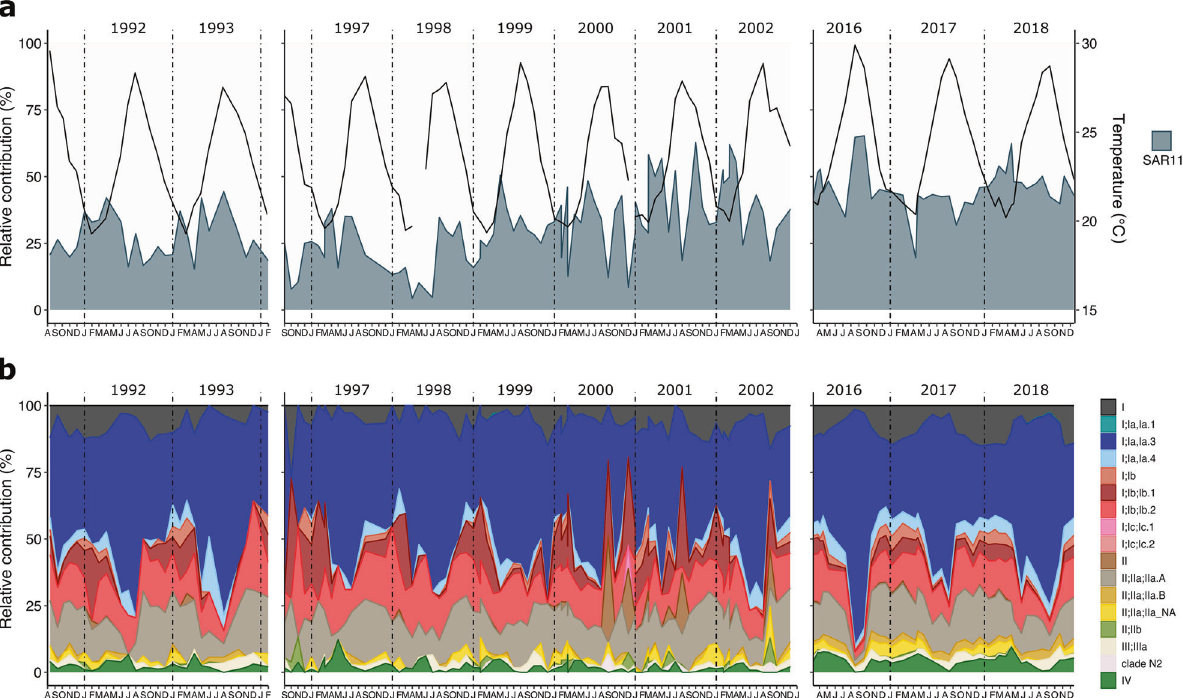
Fig. 1 Monthly relative contribution of surface SAR11 ecotypes through multiannual 16S rRNA surveys at the Bermuda Atlantic Time Series. a Monthly relative contribution of the SAR11 fraction to the total of the amplicon dataset. The black line represents temperature through the sampled years. b Monthly relative contribution of ecotypes to the total SAR11 fraction. Samples from 1991 – 1994 and 1996 – 2002 were sequenced using 454 FLX technology, while 2016 – 2018 were sequenced using the Illumina MiSeq